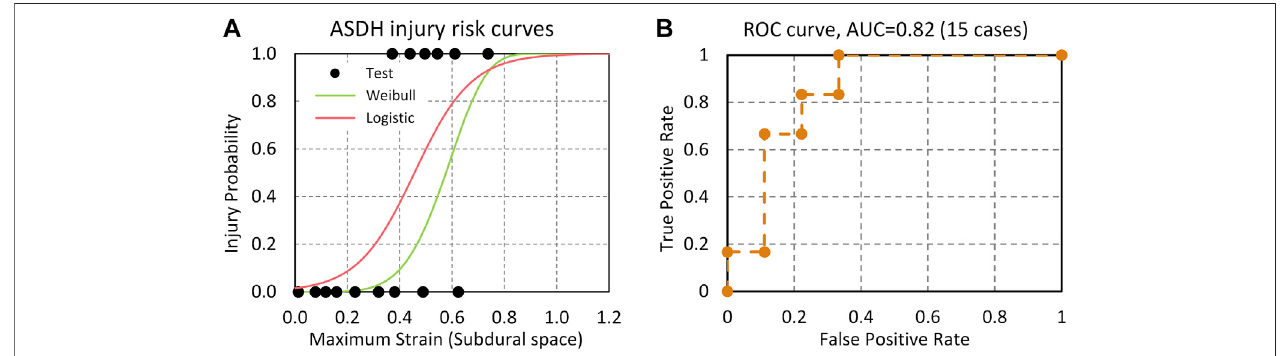
FIGURE 10 | (A) ASDH risk curves predicted by the BV strain based on Logistic regression and Weibull survival analysis models; (B) ROC curve and AUC